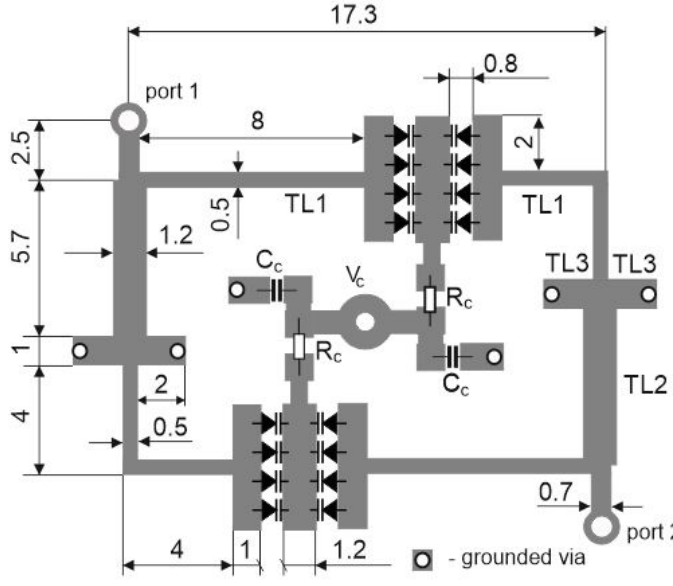
Figure 10. Layout of the proposed tunable bandpass